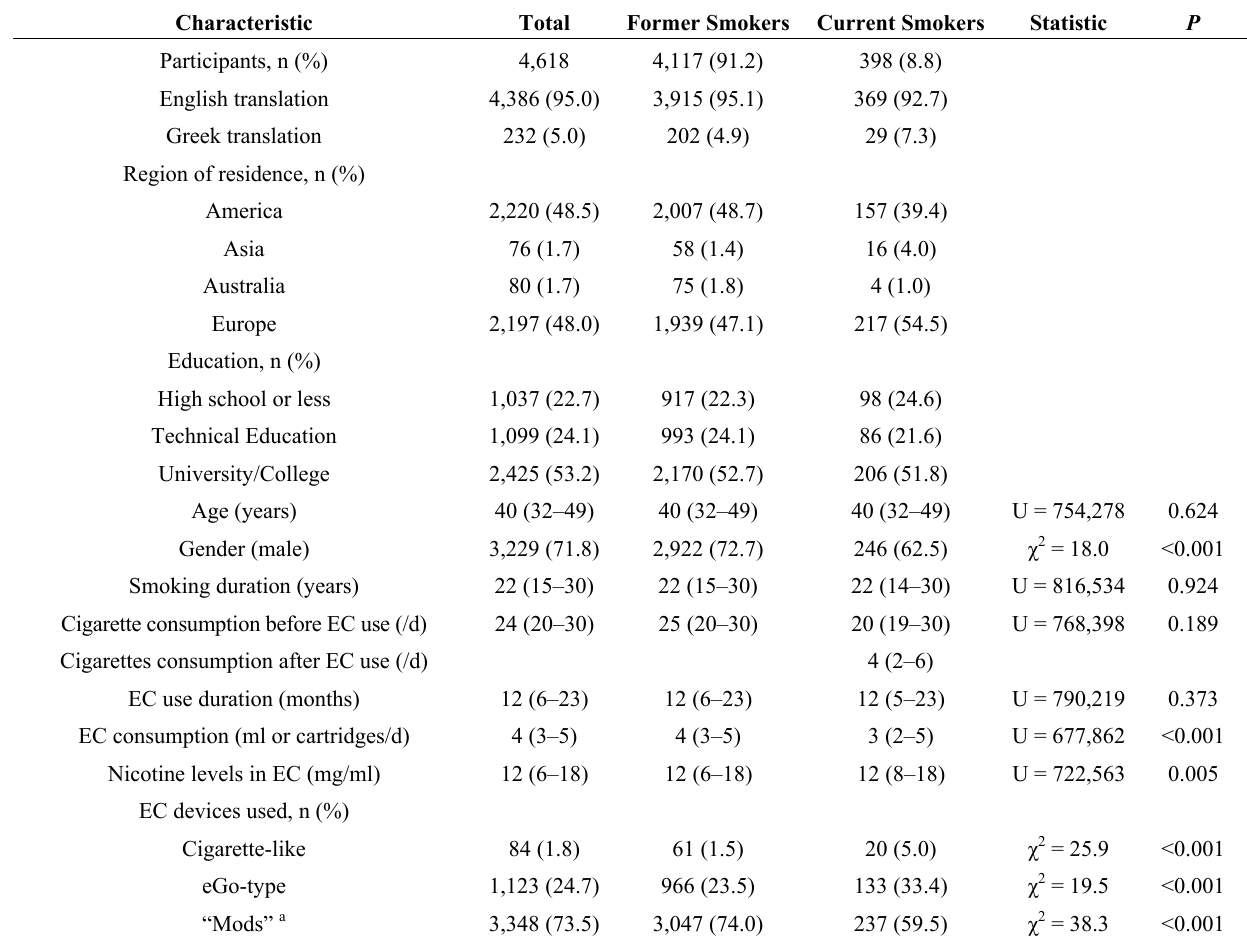
Table 1. Baseline characteristics of the study population and subgroups.